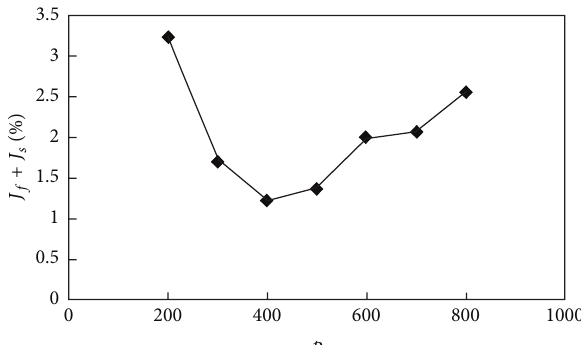
Figure 5: Validation of the proposed rule for setting of 𝑝 ( 𝑡 = 10 −8 , real dataset : “ School of Engineering in Naples